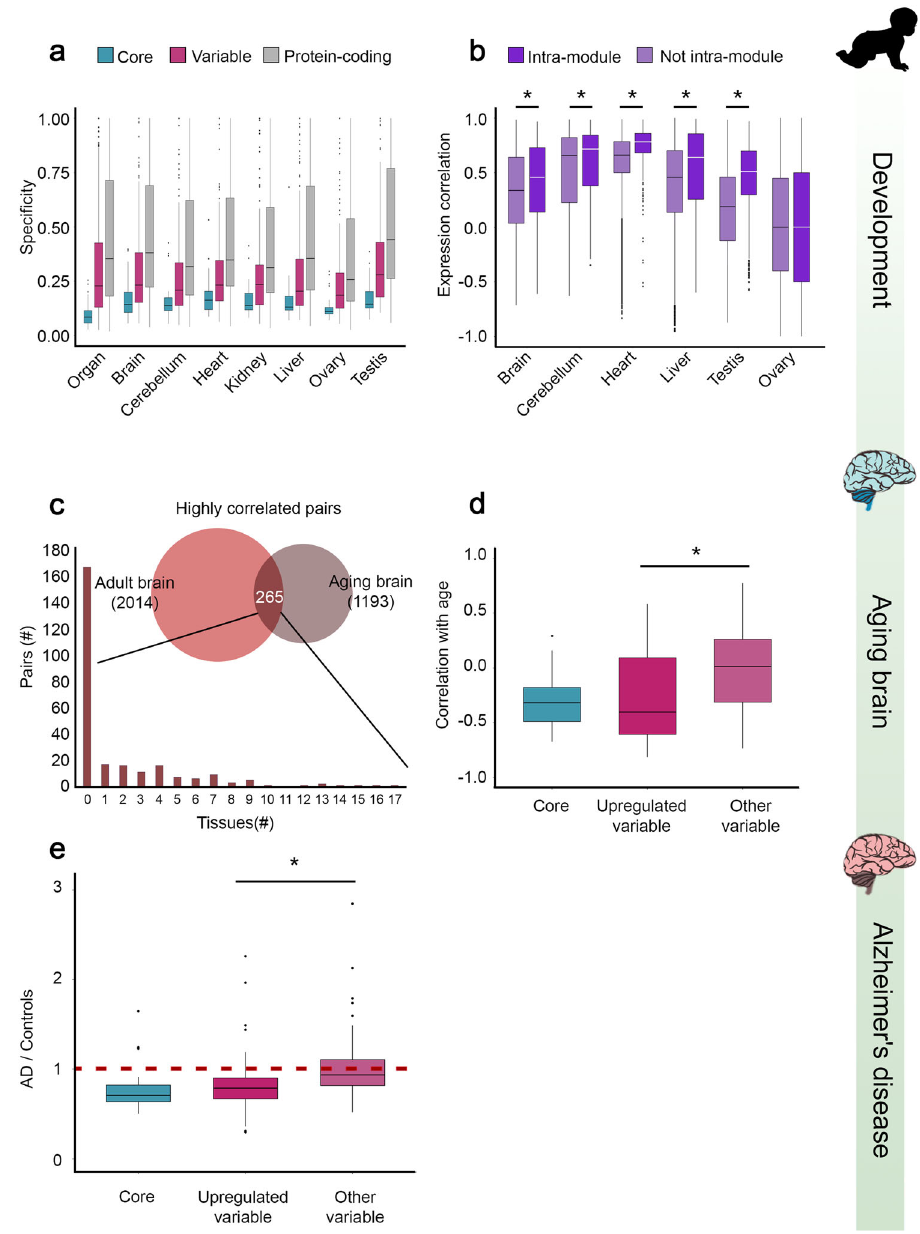
(Fig. 2c), supporting the biological relevance of differential tissue transcriptomic pro fi